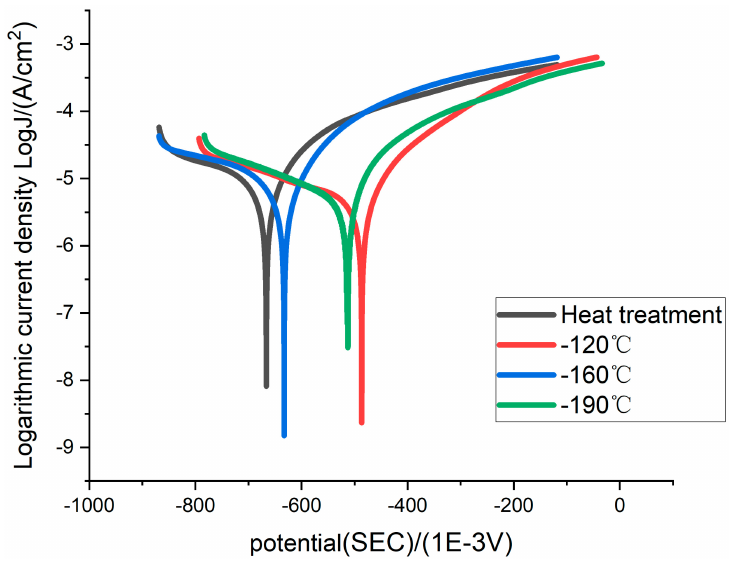
Figure 4. 42CrMo alloy steel polarization